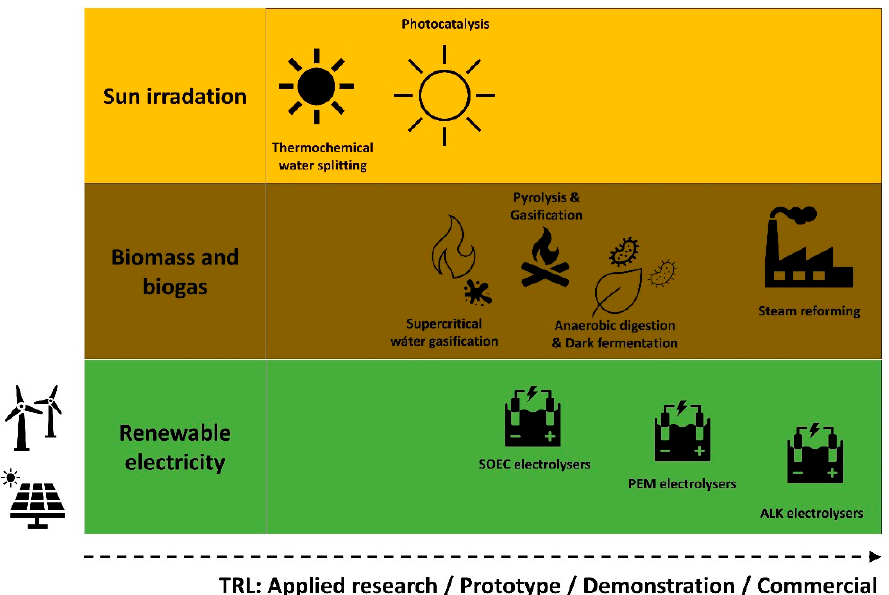
Figure 5. Renewable hydrogen pathways and current levels of maturity. TRL stands for technology readiness level (redrawn from the original source [61]).